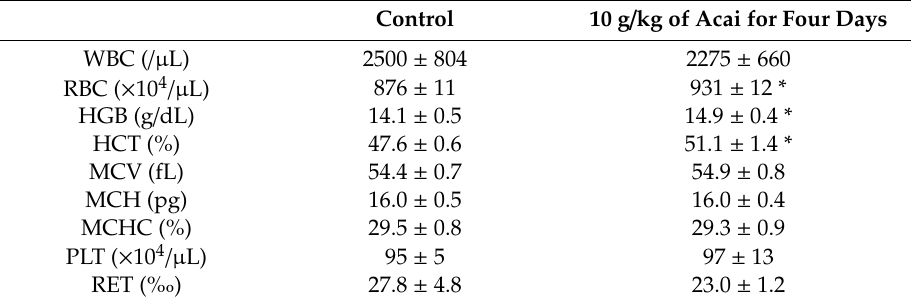
Table 2. E ff ect of acai extract on the hematological parameters in mice ( n = 4).